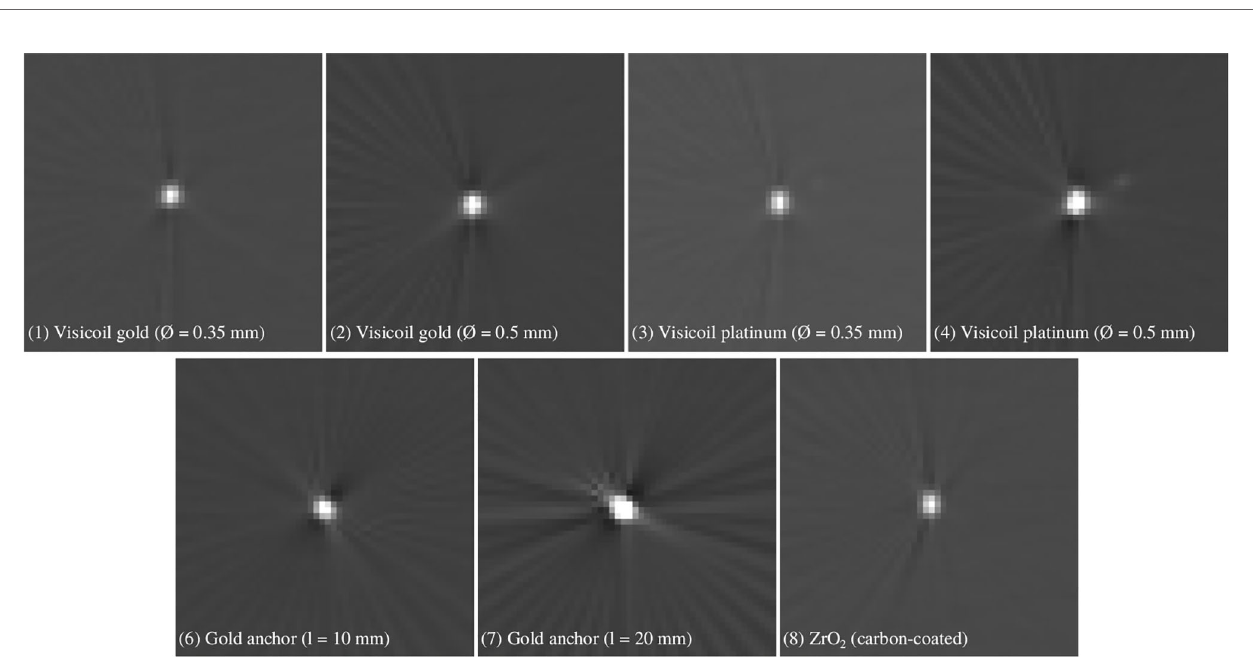
FIGURE 7 | In-room mobile CT images of 7 different fi ducial markers listed in Table 1 .